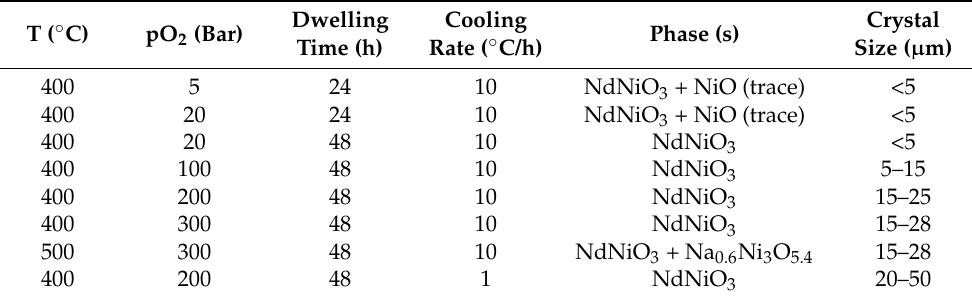
Table 1. Growth conditions of NdNiO 3 crystals.